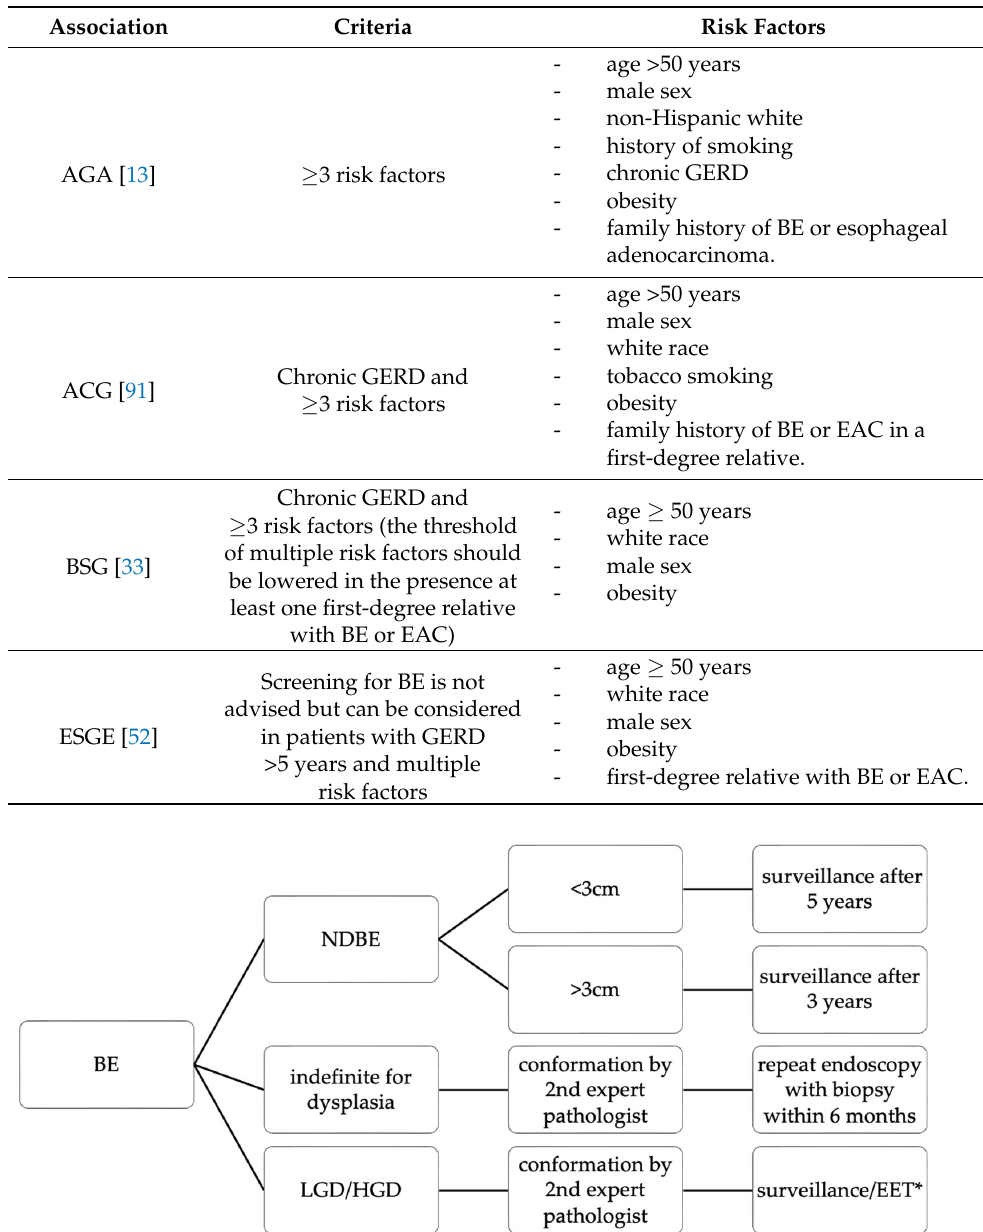
Table 2. Criteria for BE screening.